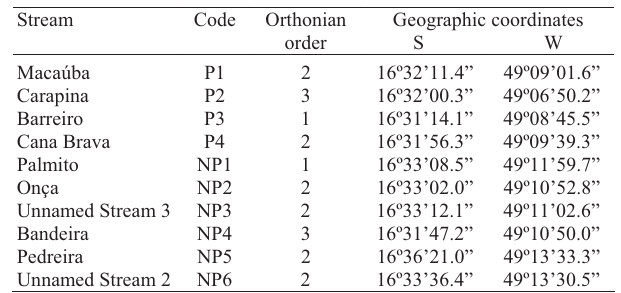
Table 1. Geo-reference of stream stretches in the João Leite River basin, Goiás, Central Brazil. Stream codes and orthonian order of the stretch sampled are